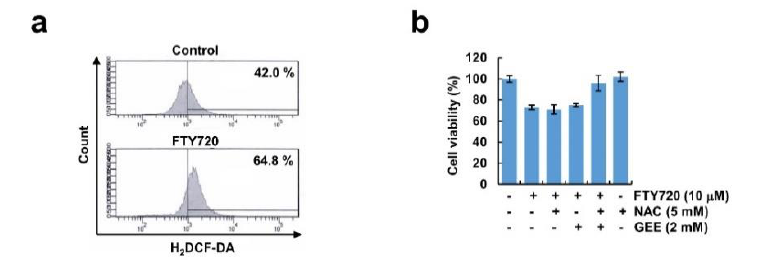
Figure 6. Reactive oxygen species (ROS) had no effect on FTY720-induced cell death in human glioma U251MG cells. ( a ) U251MG cells were treated with 10 μM FTY720 for 3 h, and then cells were stained with H 2 DCF-DA dye. Fluorescence was detected using flow cytometry. ( b ) U251MG cells pretreated with ROS scavengers [5 mM N-acetyl-cysteine (NAC) and 2 mM glutathione ethyl ester (GEE)] for 30 min, and then added along with 10 μM FTY720 for 24 h. Cell viability was determined by XTT assay. The values in the graphs ( b ) represent the mean ± SD of three independent experiments.